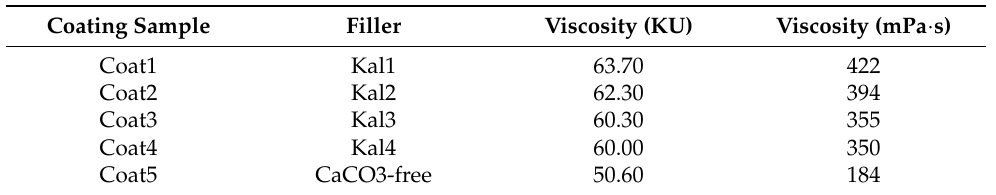
Table 3. Viscosity values measured with the Krebs Stormer viscometer in Krebs units and its equivalents in mPa · s.